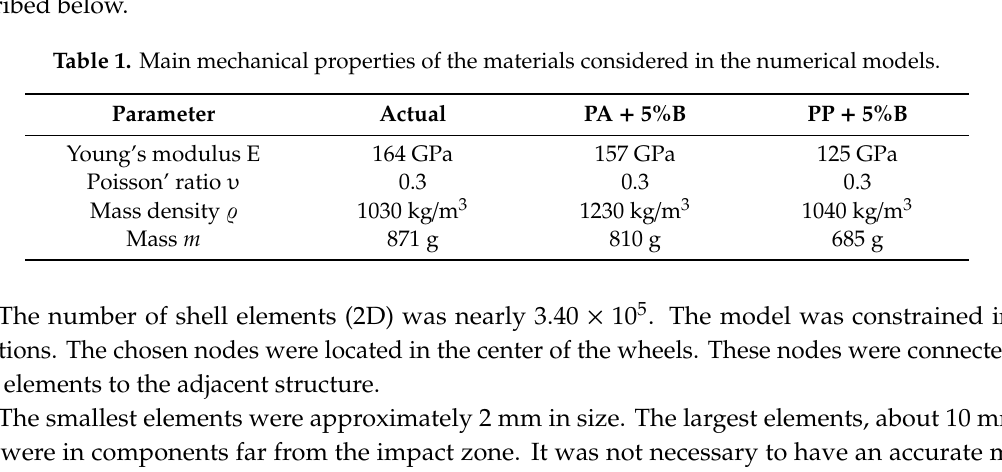
Figure 2. The FEM model considered in the analyses. Figure 3. Constitutive law (stress vs. strain) for PA + 5%B and PP + 5%B.